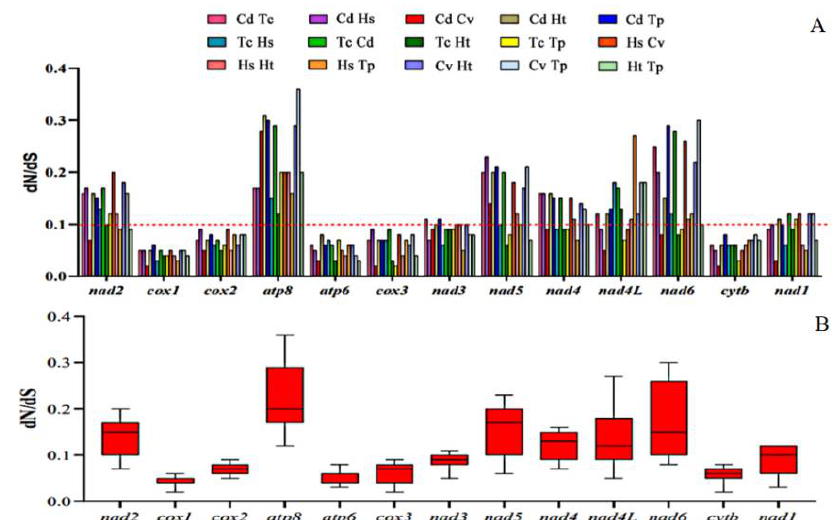
Figure 6. Proportions between rates of non-synonymous (dN) and synonymous (dS) nucleotide sub- stitutions (dN/dS). ( A ) Bar chart of the pairwise proportions of dN/dS for each of the mitochondrial subunits of the investigated species. ( B ) Box chart illustrating the averages for pairwise proportions of dN/dS for each of the mitochondrial subunits of the investigated species. The dN/dS ratios are plotted on the y -axis, and the PCGs are plotted on the x -axis.